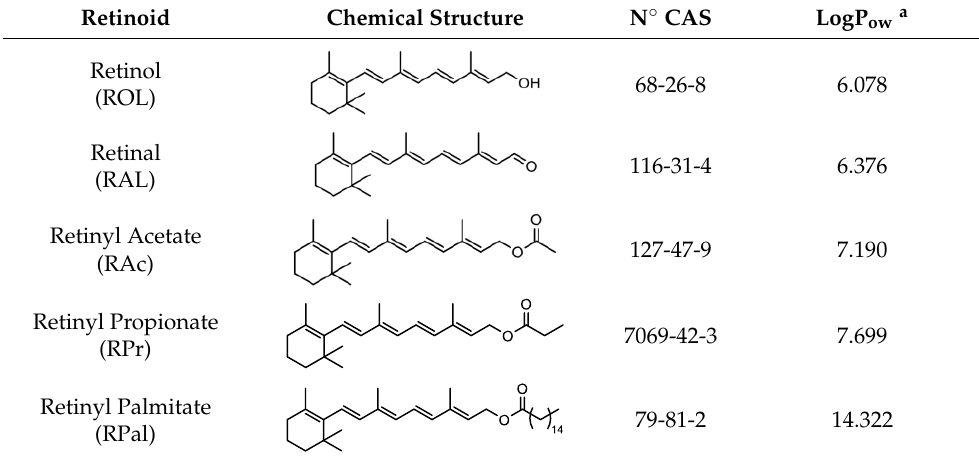
Table 1. Chemical structure and some relevant data of the target analytes. Retinoid